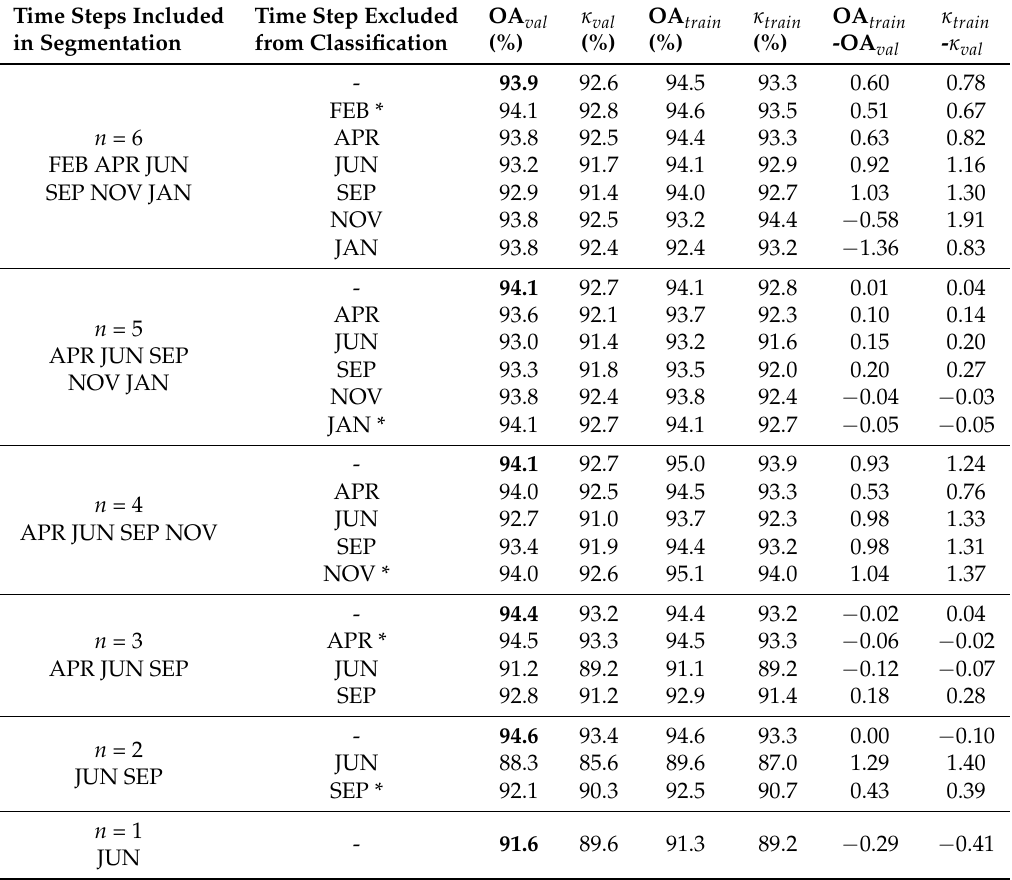
Table 2. Classification accuracy with step-wise decrease in the number of time steps. The * indicates the time step which adds the least value. This time step is the group of 18 attributes collected for